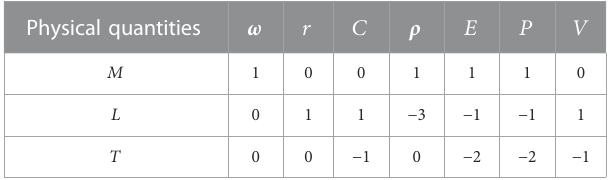
TABLE 3 Expressions for the each physical quantity magnitude.